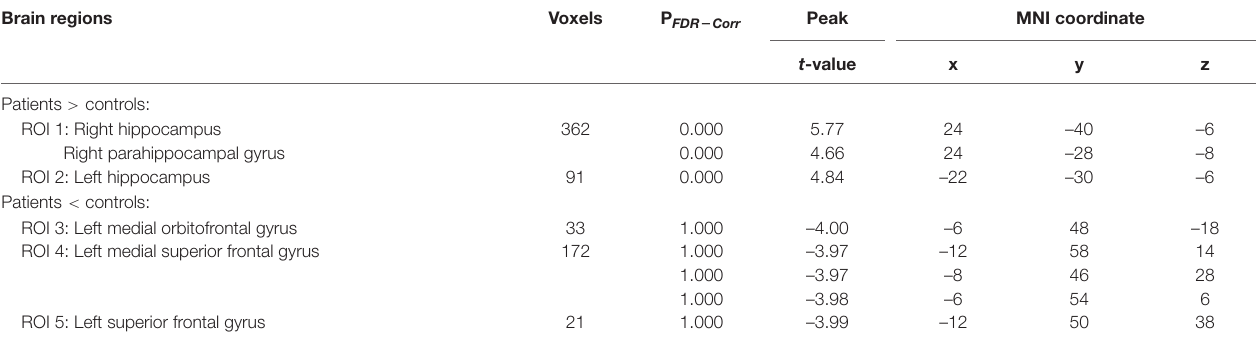
FIGURE 1 | Difference maps of regional brain glucose metabolism between the post-chemotherapy group and the control group. Red to yellow areas represent the regions where the brain glucose metabolism values were higher in the post-chemotherapy group, while blue to cyan areas represent the opposite ( p < 0.05, FDR correction). (A) Axial image showing the ROI 1 (white arrow) in the right hippocampus and parahippocampal gyrus, and ROI 2 (black arrow) in the left hippocampus. (B) Coronal image showing the ROI 1 and the ROI 2. (C) Sagittal image showing the ROI 1. (D) Axial image showing the ROI 3 in the left medial orbitofrontal gyrus. (E) Axial image showing the ROI 4 in the left medial superior frontal gyrus. (F) Axial image showing the ROI 5 in the left superior frontal gyrus. (G) Sagittal image showing ROI 3, 4, and 5 from bottom to top. TABLE 2 | The difference of regional brain glucose metabolism between chemotherapy-treated DLBCL patients and controls. Brain